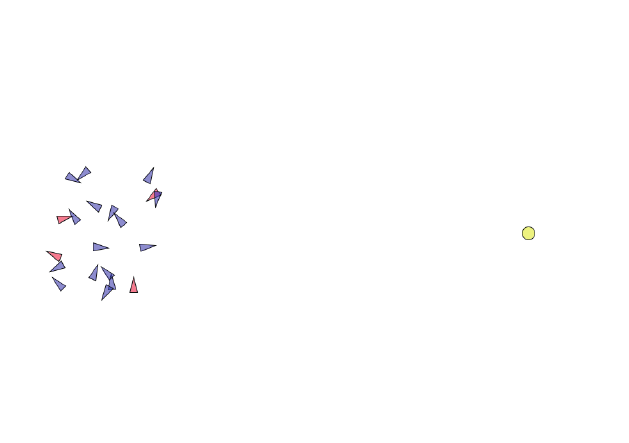
Figure 1: Initial con(cid:12)guration of the problem. The purpose of boids (triangle) is to chase a target (cir- cle) without collapsing